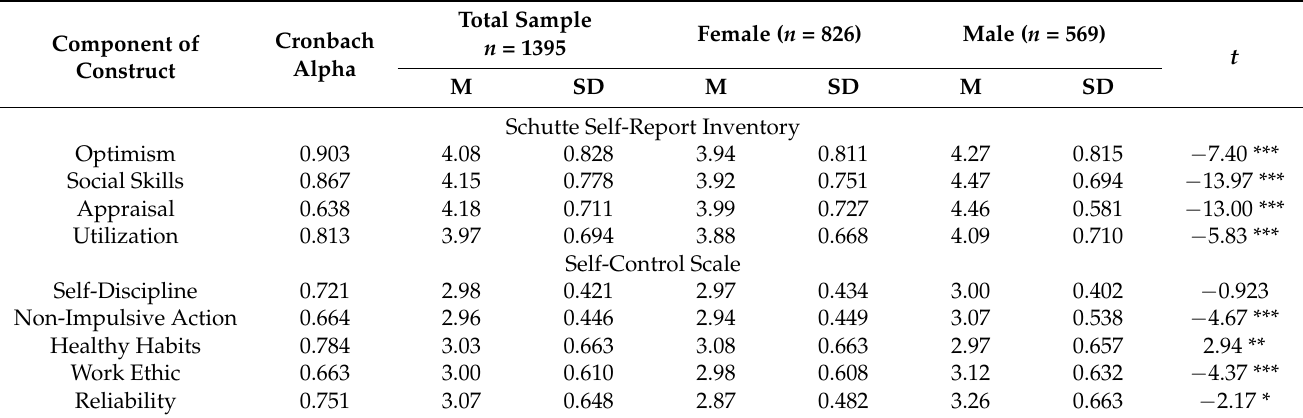
Table 1. Cronbach alpha, means, and standard deviation of the variables of the total sample and by gender, and Student t